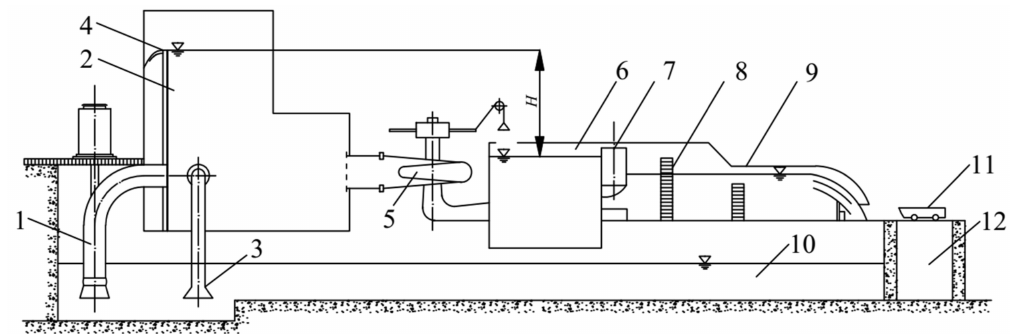
Figure 8. The CAD representation of the test loop, where 1-pump, 2-head tank, 3-bypass valve, 4-overflow plate, 5-Kaplan turbine model, 6-draft tank, 7-regulating grid, 8-stabilizing grid, 9-flow